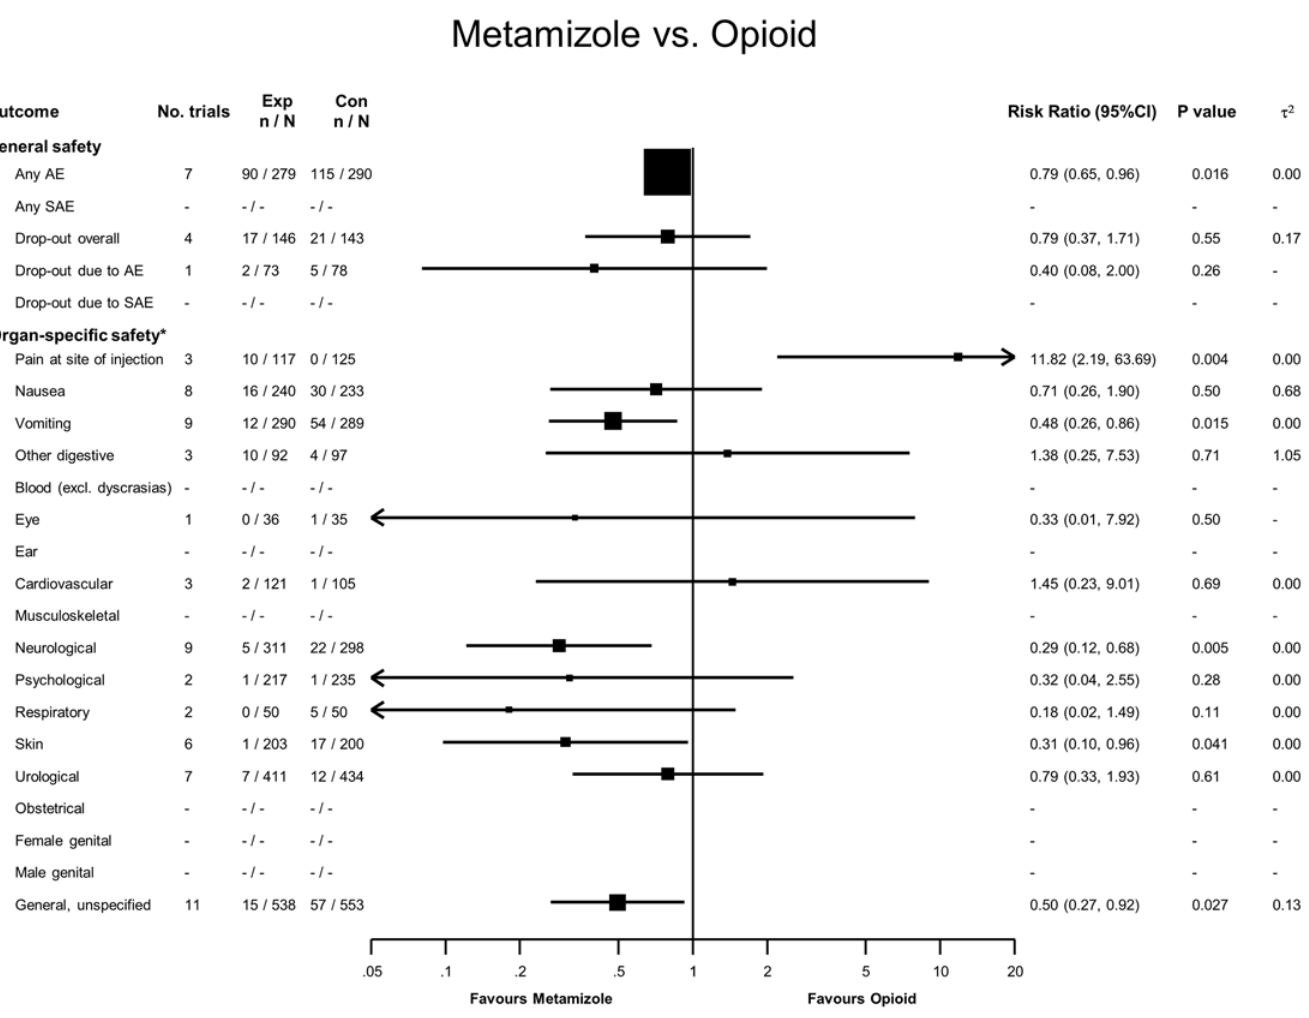
Fig 6. Forest plot — Metamizole versus Opioids. Categories according to the International Classification of Primary Care (see Methods section and [13]). Results from single studies are of limited interpretability but are displayed for the sake of completeness. RR = risk ratio. AE = adverse events. SAE = serious adverse